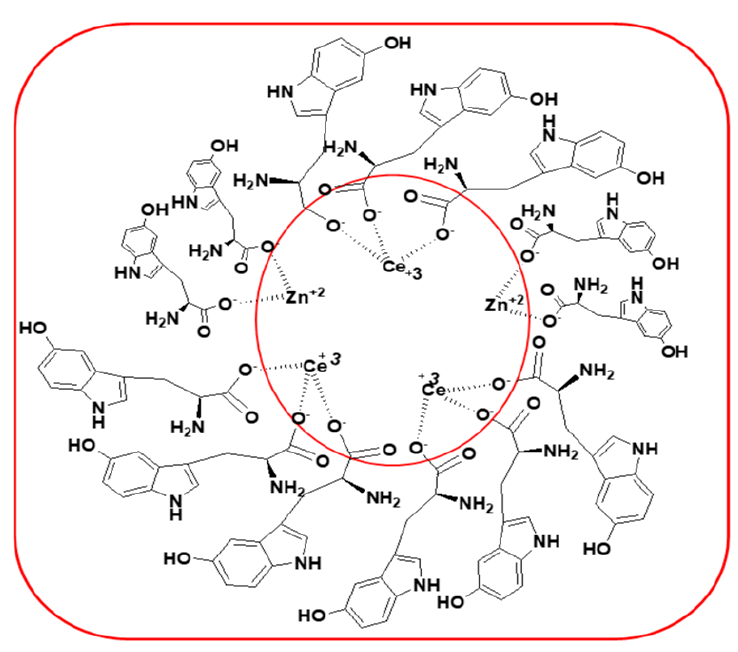
Figure 2. Interaction of ions between metals and amino acids.